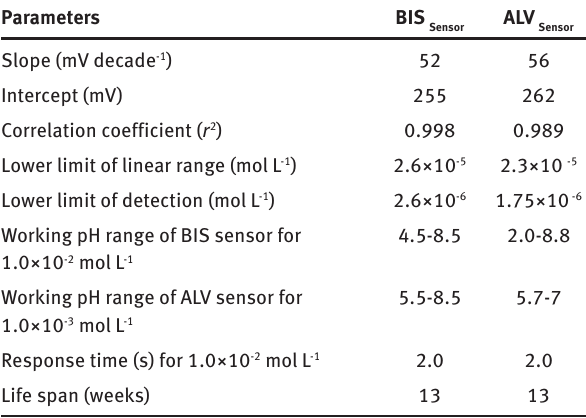
Table 1: Response characteristics of BIS and ALV sensors